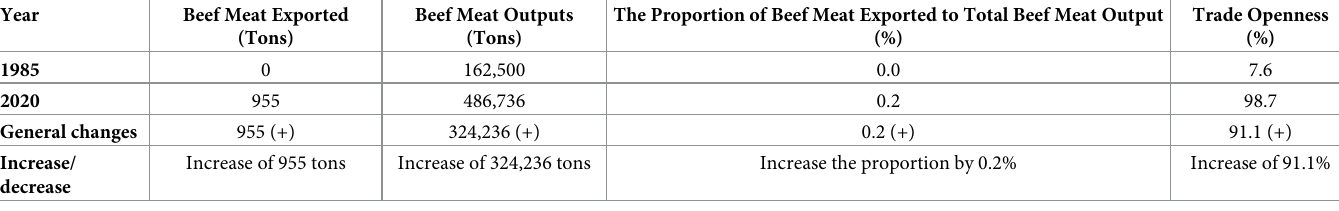
Table 4. General changes and relationships between beef meat exported beef meat output and trade openness from 1985 to